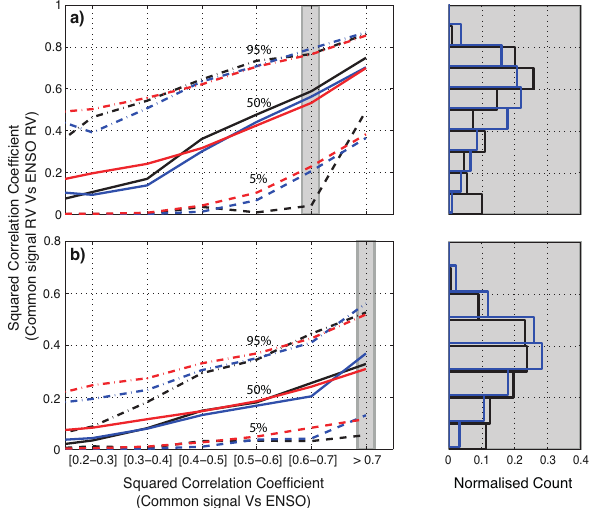
Figure 3: a) displays the 5% (dashed lines), 50% (solid lines) and 95% (dash-dot lines) of 2 Fig. 3. (a) displays the 5% (dashed lines), 50% (solid lines) and squared correlation coefficients calculated between CM2.1 simulated precipitation running 3 variance (calculated in a 30-yr sliding window) and ENSO running variance, binned on the x- 4 95% (dash-dot lines) of squared correlation coefficients calculated axis against the squared correlation between the simulated precipitation and ENSO. The color of 5 between CM2.1 simulated precipitation running variance (calcu- the lines indicates the number of source locations utilized in the precipitation signal, with black, 6 lated in a 30yr sliding window) and ENSO running variance, binned blue and red lines corresponding to one, two and five source locations. The inset histogram 7 displays the distribution of squared correlation coefficients calculated between precipitation 8 on the x axis against the squared correlation between the simulated running variance and ENSO running variance from the x-axis bin of the main plot shaded grey. 9 precipitation and ENSO. The color of the lines indicates the number b) as in a) but for CCSM4 model output. Note the different Y-axis for panels a) and b). 10 11 of source locations utilized in the precipitation signal, with black, blue and red lines corresponding to one, two and five source loca- tions. The inset histogram displays the distribution of squared cor- relation coefficients calculated between precipitation running vari- ance and ENSO running variance from the x axis bin of the main plot shaded grey. (b) as in (a) but for CCSM4 model output. Note the different y axis for panels (a) and (b)